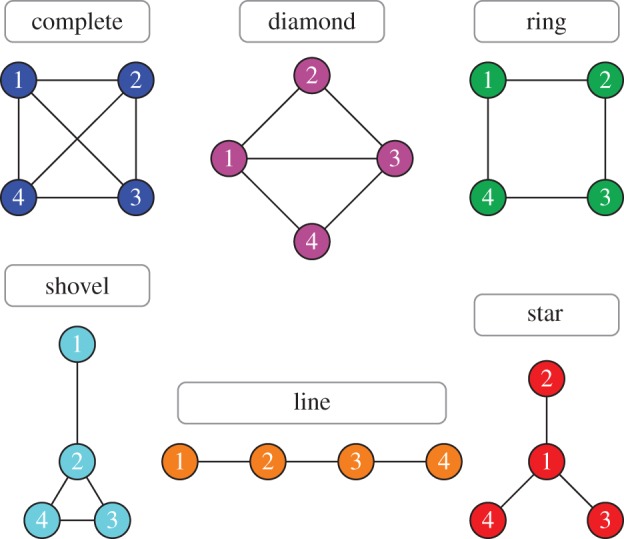
The six possible connected undirected networks of size N = 4. The complete graph (which corresponds to the well-mixed population) and the ring are isothermal (homogeneous) networks, implying that the fixation probabilities on these networks are identical. The other four networks are degree heterogeneous and thus not isothermal. (Online version in colour.)